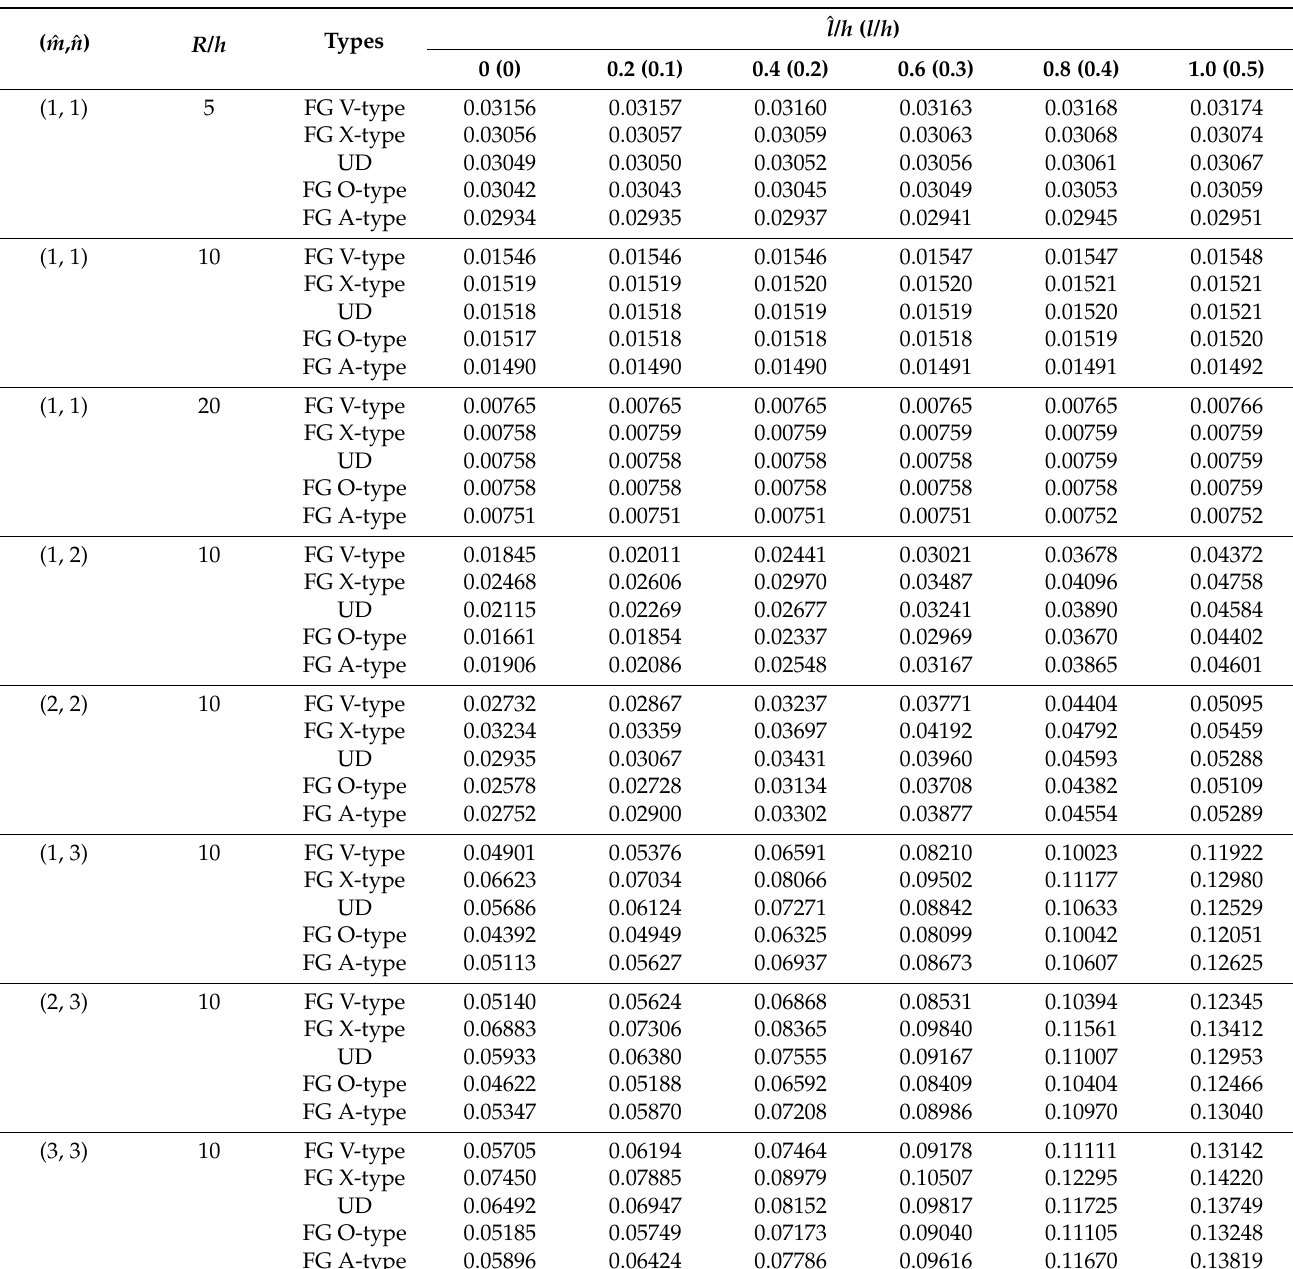
Table 4. Solutions for the lowest frequency parameters ω of FG-GPLRC cylindrical microshells obtained using three-node Hermitian C 2 FEM, with different wave number values, n l = 20, L / R = 10 (cid:112) ρ epoxy / E epoxy and ω = ω h